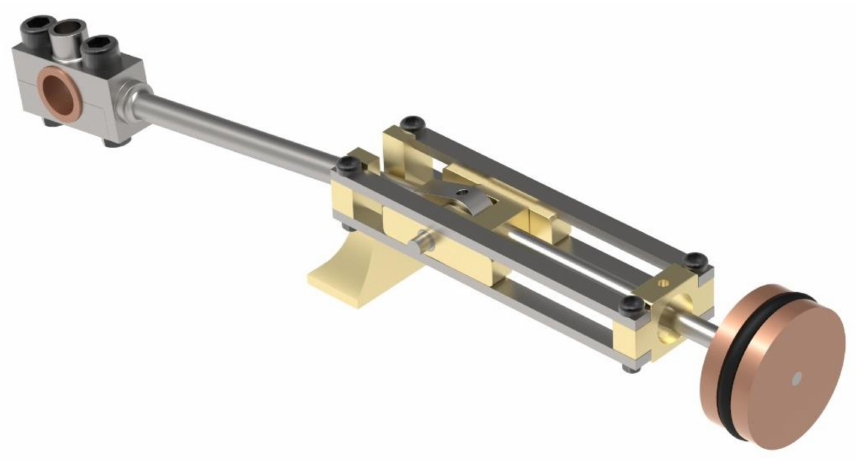
Figure 10. Piston